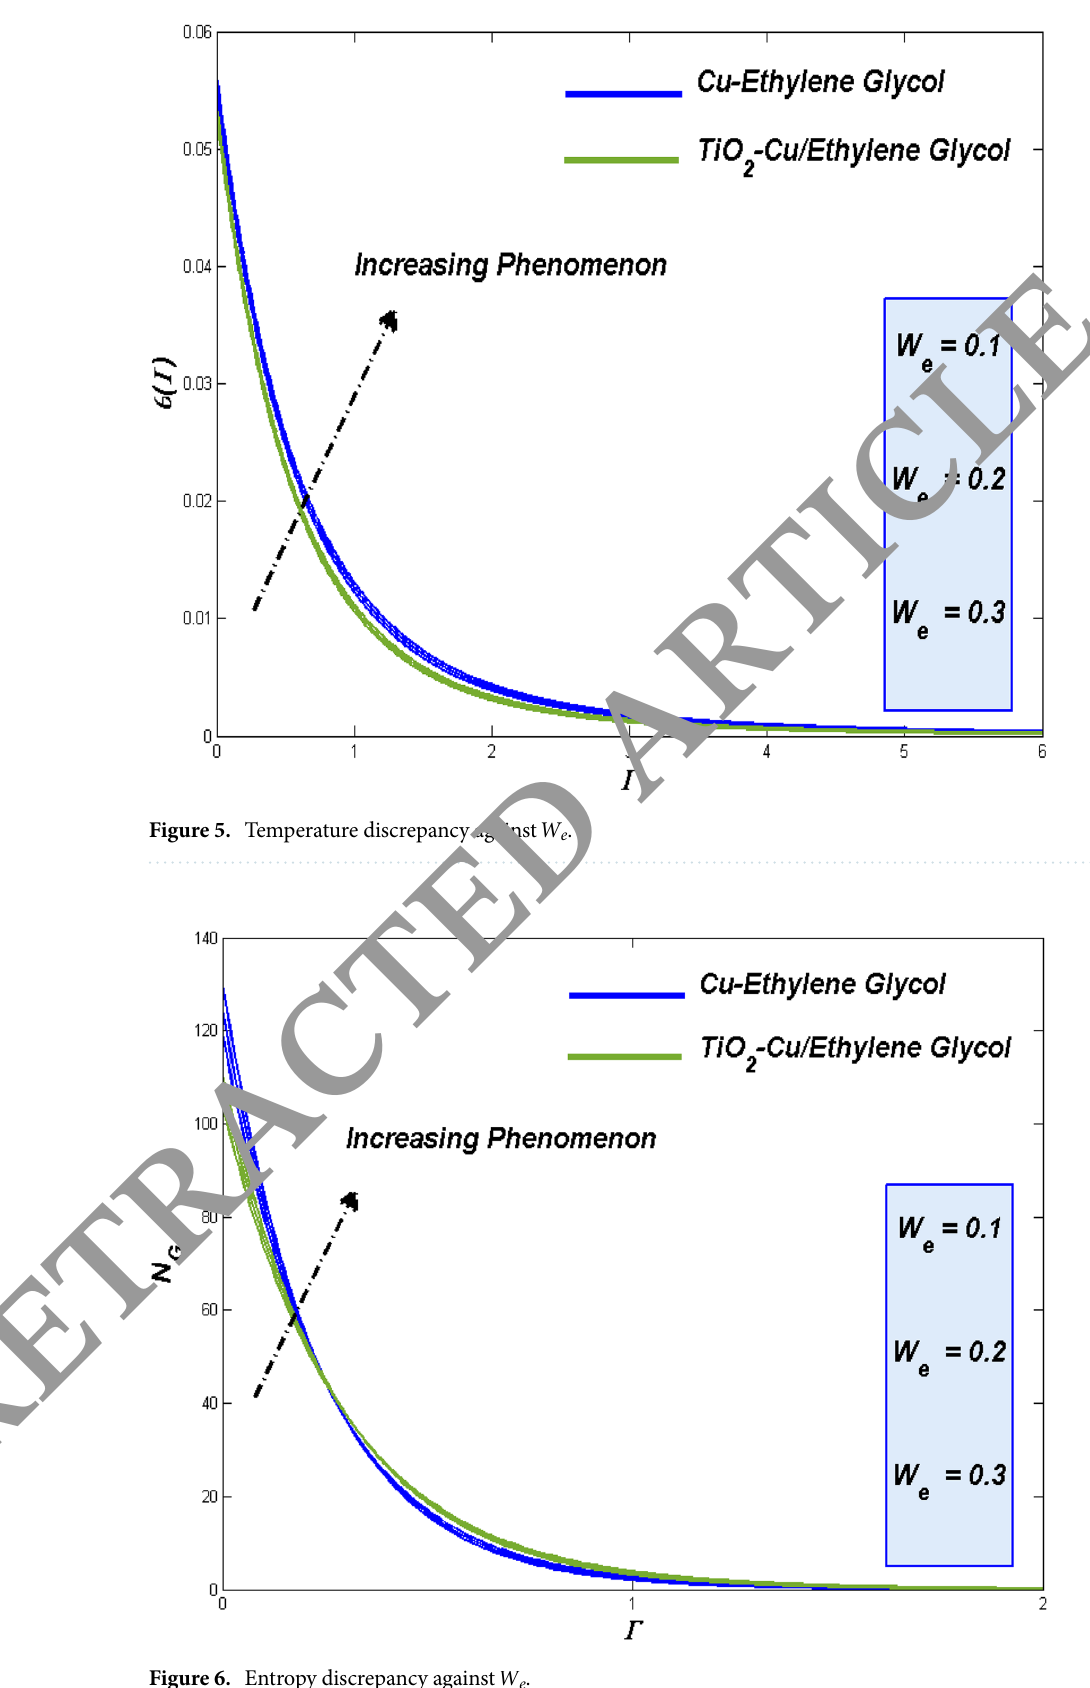
Figure 6. Entropy discrepancy against W e